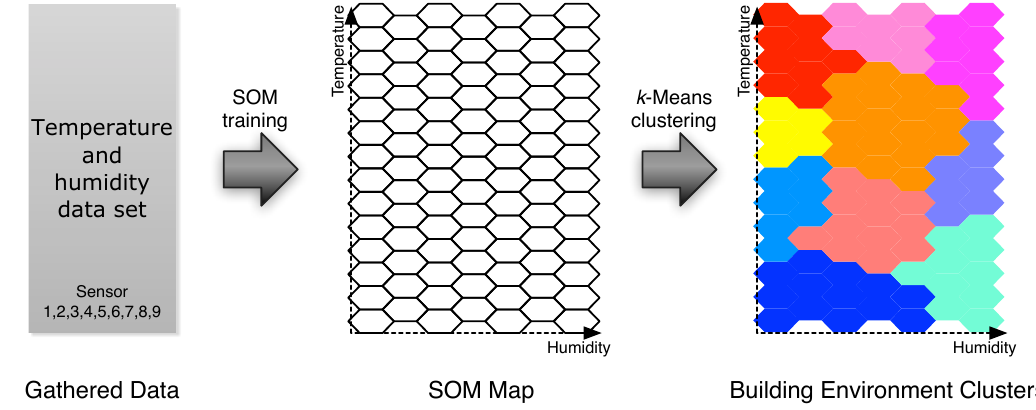
Figure 4. Clustering method of building environments based on temperature and humidity using Kohonen Self-Organizing Maps (SOM) and k -Means algorithm.